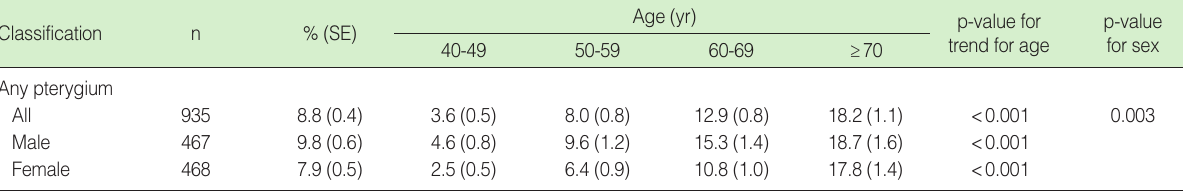
SE, standard error. Table 3. The age- and sex-specific proportion rates according to the grades of pterygium Pterygium n % (SE)